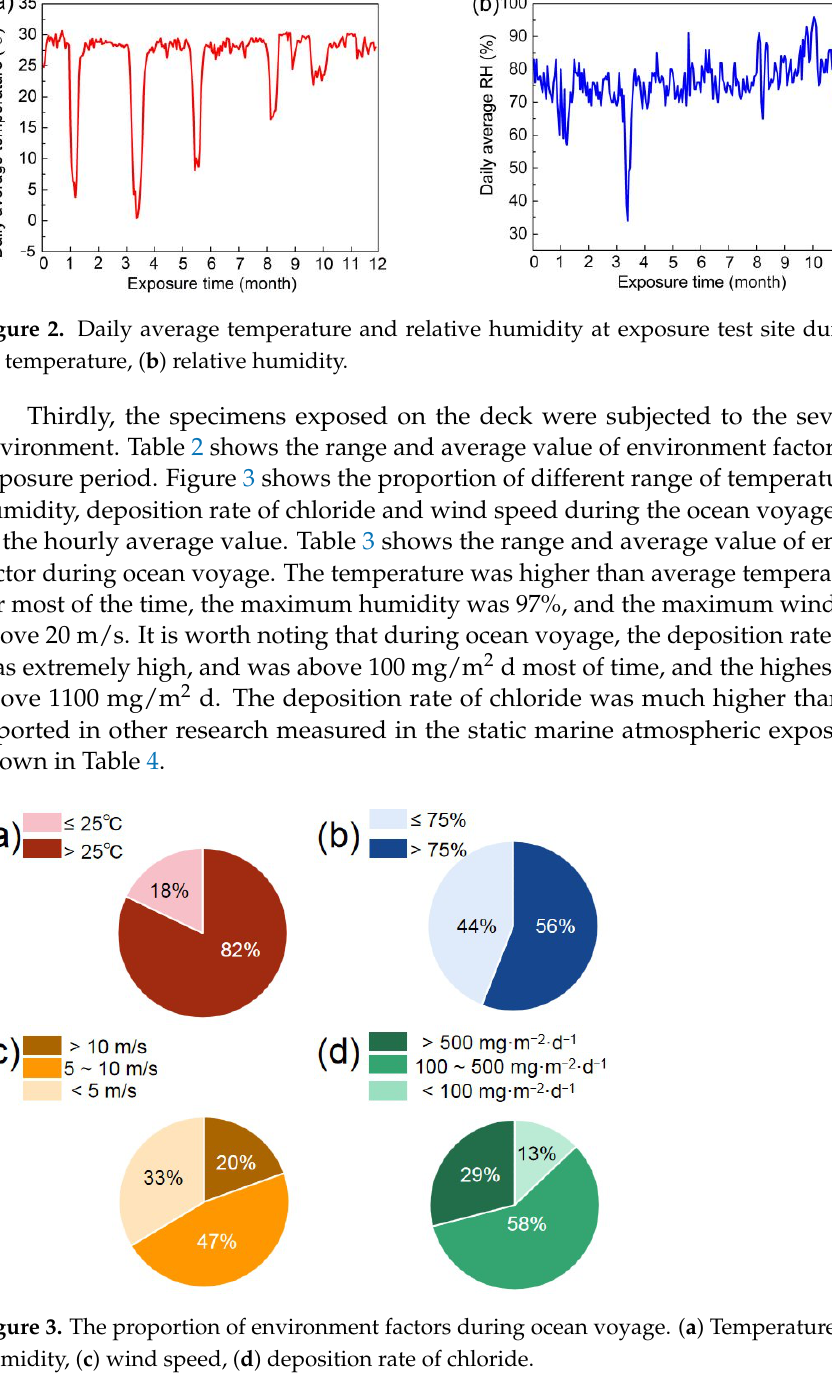
Figure 3. The proportion of environment factors during ocean voyage. ( a ) Temperature, ( b ) relative humidity, ( c ) wind speed, ( d ) deposition rate of